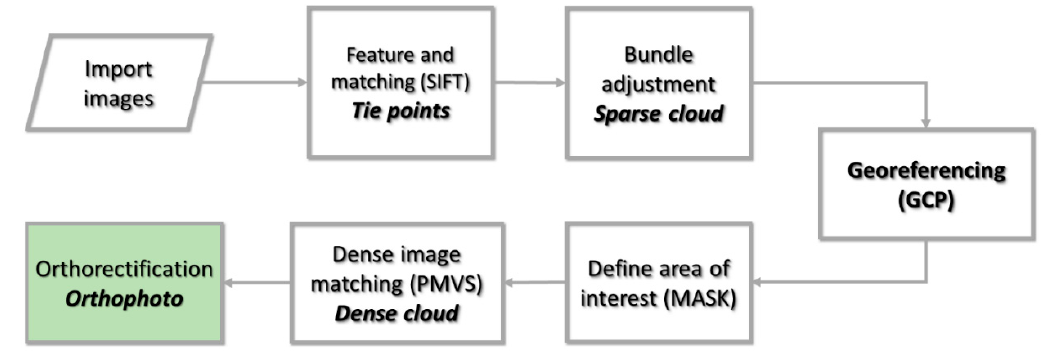
Figure 3. Structure from Motion processing workflow.The aerial photogrammetry was useful to identify morpho-topographic features that are not clearly visible from the ground level. Moreover, it was a time-efficient method to produce cartographic outputs usable in GIS. The most important output obtained was the georeferenced orthophoto which was imported in the QGIS open-source software for the environmental characterization phase. This methodology allows a choice of sampling points using an updated map of the study area, which is affected by frequent coastline and morphological variations due to storm surges. Two main strategies can be followed to choose the location of the sampling points:.